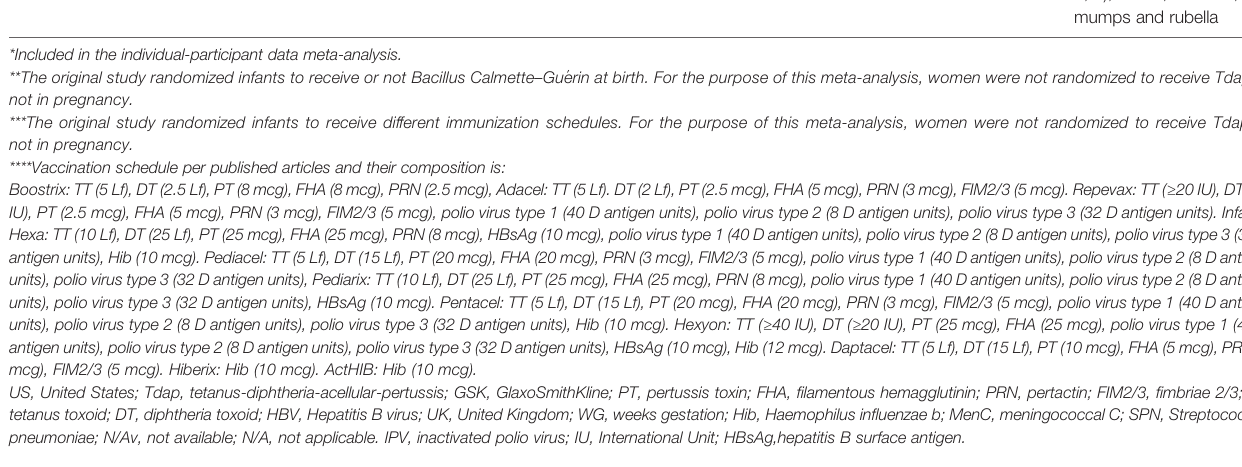
0.84), respectively ( Figure 2B ). Infants of women immunized with Tdap in pregnancy had signi fi cantly lower anti-PRN IgG levels compared with infants of women who did not receive Tdap in pregnancy post-primary and pre-booster